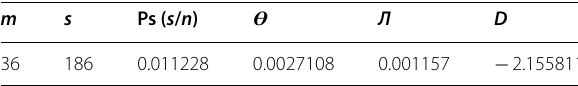
Table 2 Results from Tajima’s neutrality test